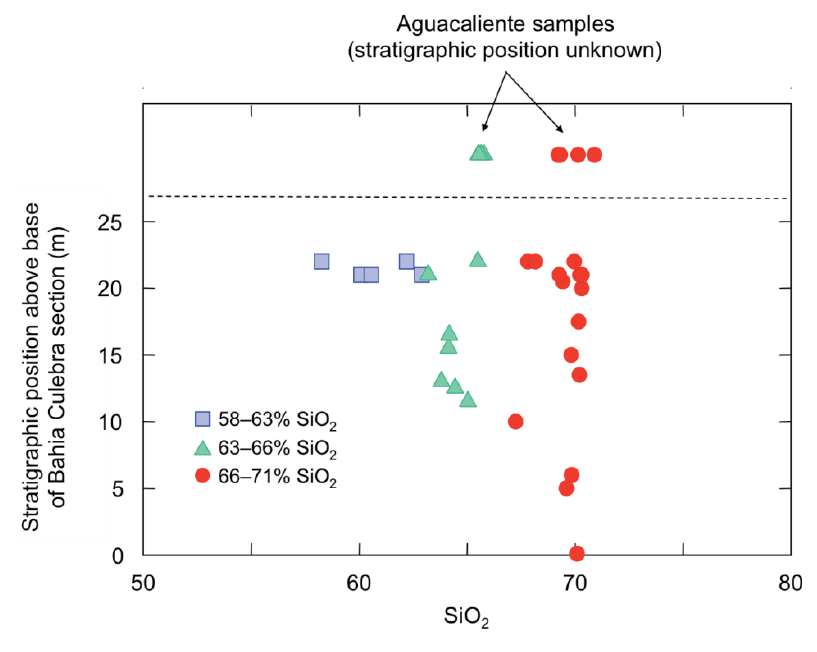
Figure 14. SiO content plotted against the stratigraphic position of each sample in the 2 continuous 23-m section of the Papagayo Tuff exposed at Bahía Culebra (location “1” in Figure 1). Note that the stratigraphic position of samples taken from the Aguacaliente locality (shown at the top of the diagram) is uncertain.